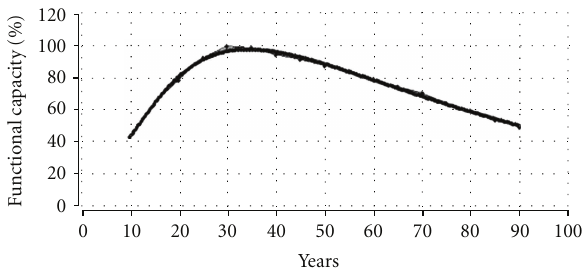
Figure 5: Life trajectory simulation of the functional capacity in human beings [11,